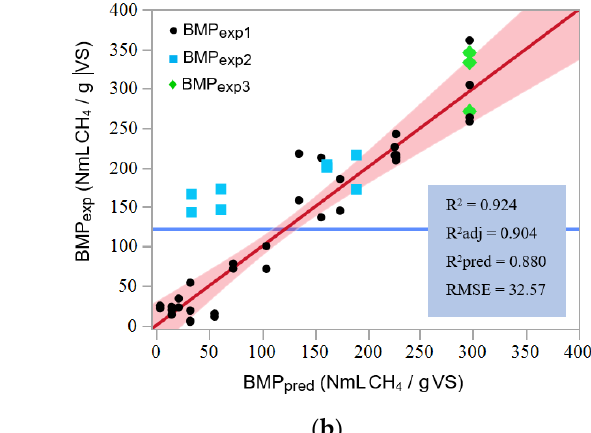
Figure 1. Mean of the BMP and respective standard deviation (SD), and operating conditions for each experiment.